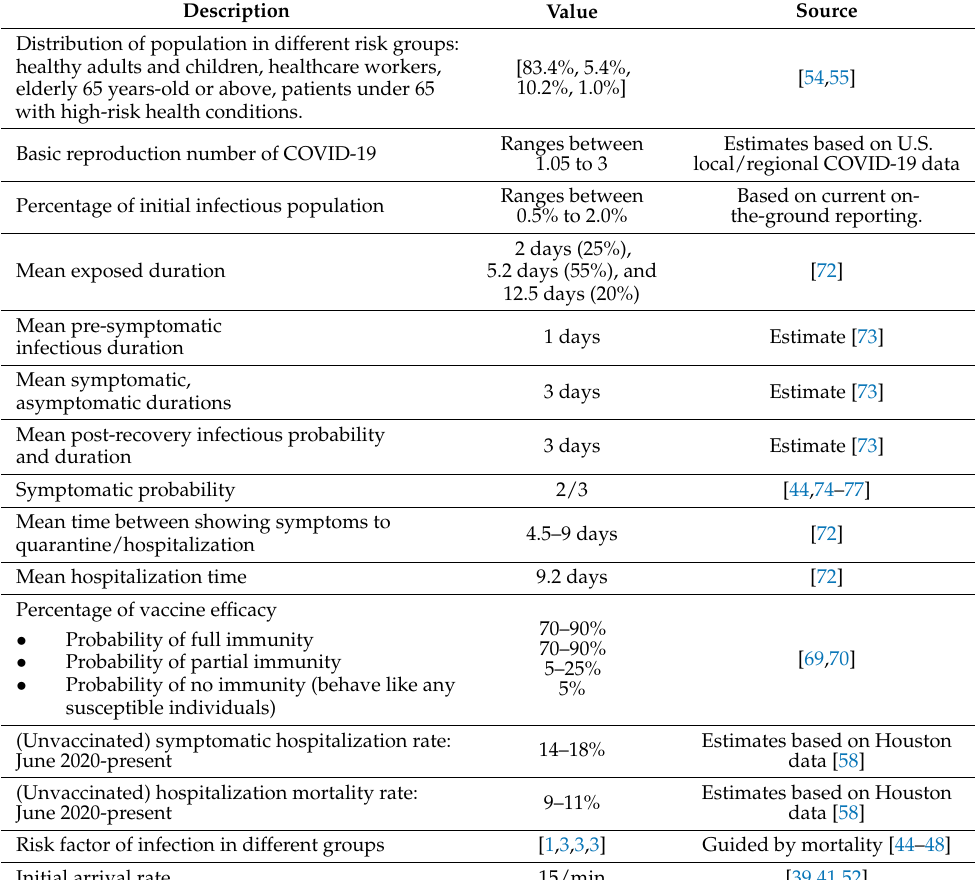
Table A1. Values of parameters used in our empirical